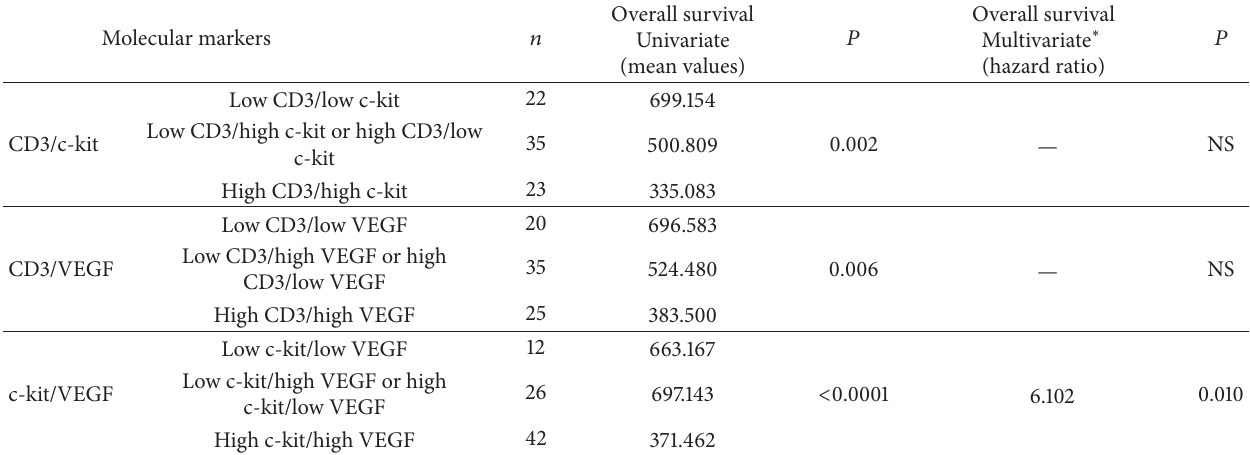
Table 2: Association between considered molecular markers groups and overall survival.